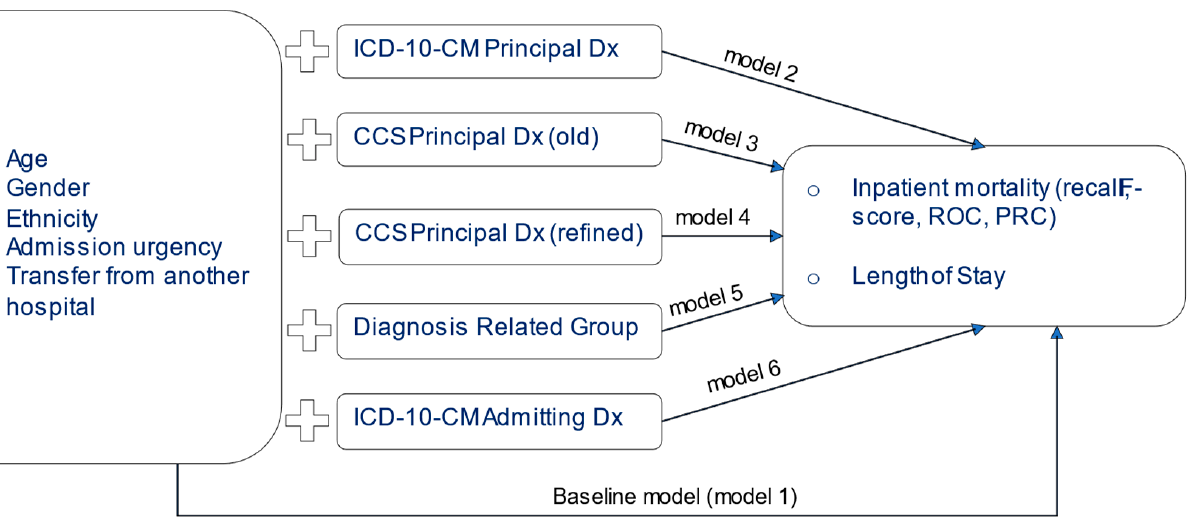
Figure 1. Summary of Experimental Design.